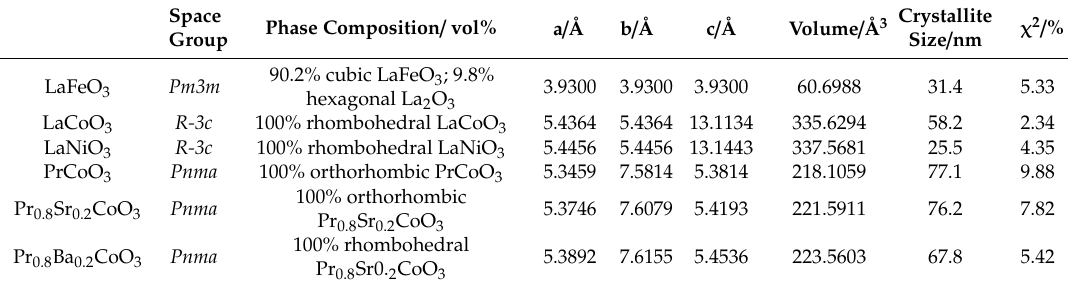
Table 1. Rietveld refinement results of XRD patterns for La- and Pr-based perovskites.